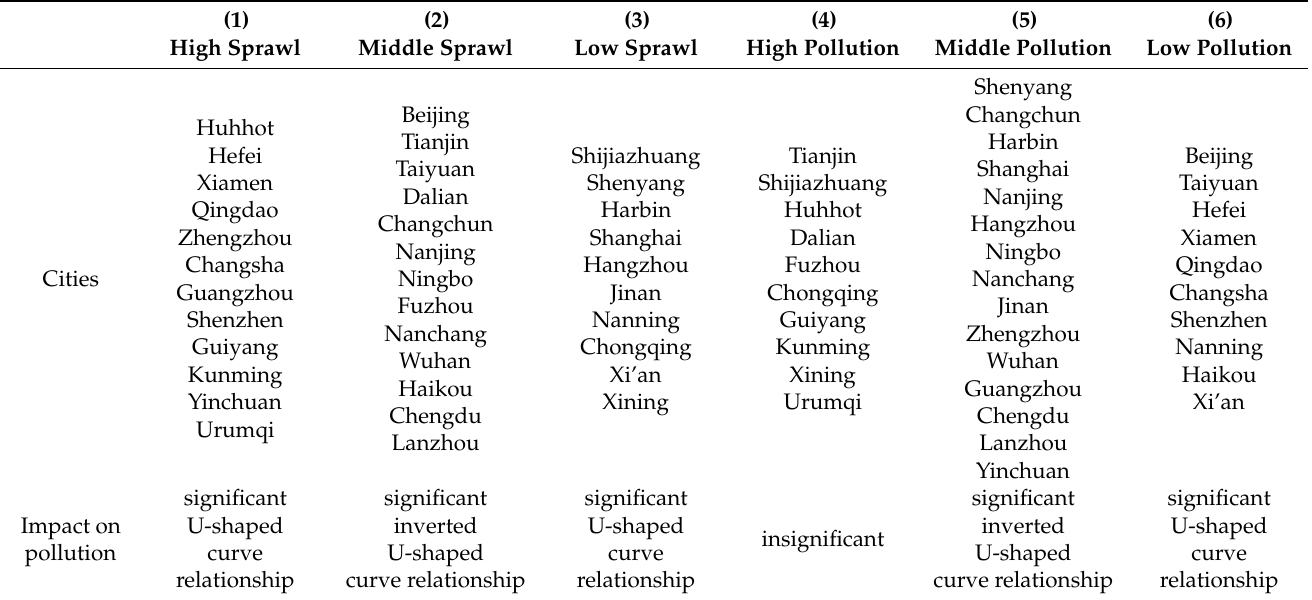
Table 9. Detailed classification and impact